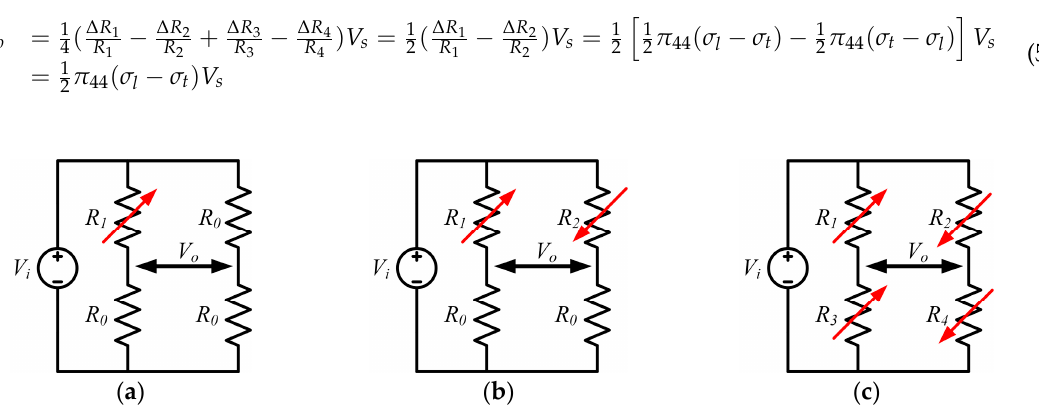
Figure 3. Different configurations of Wheatstone bridge in piezoresistive sensors. ( a ) Quarter bridge; ( b ) Half bridge; ( c ) Full bridge.